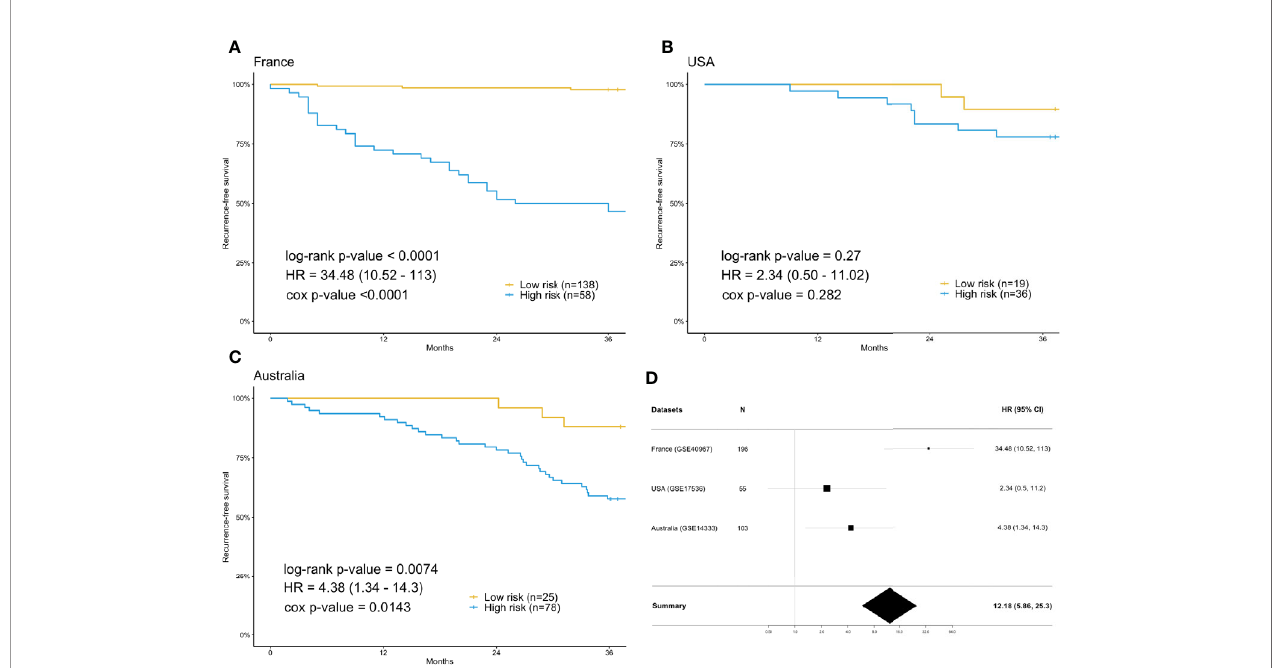
FIGURE 2 | Survival analysis using the training data set (France) and validation data sets (USA & Australia). (A) Kaplan-Meier plot for France (n=196) data set. (B) Kaplan-Meier plot for USA (n=55) data set. (C) Kaplan-Meier plot for Australia (n=103) data set. (D) Forest plot of the hazard ratio and 95% con fi dence intervals in both the training data set and validation data sets. The prediction of high or low risk groups was dependent on majority voting. The P-values correspond to the two- sided log-rank test determining the difference between two curves.